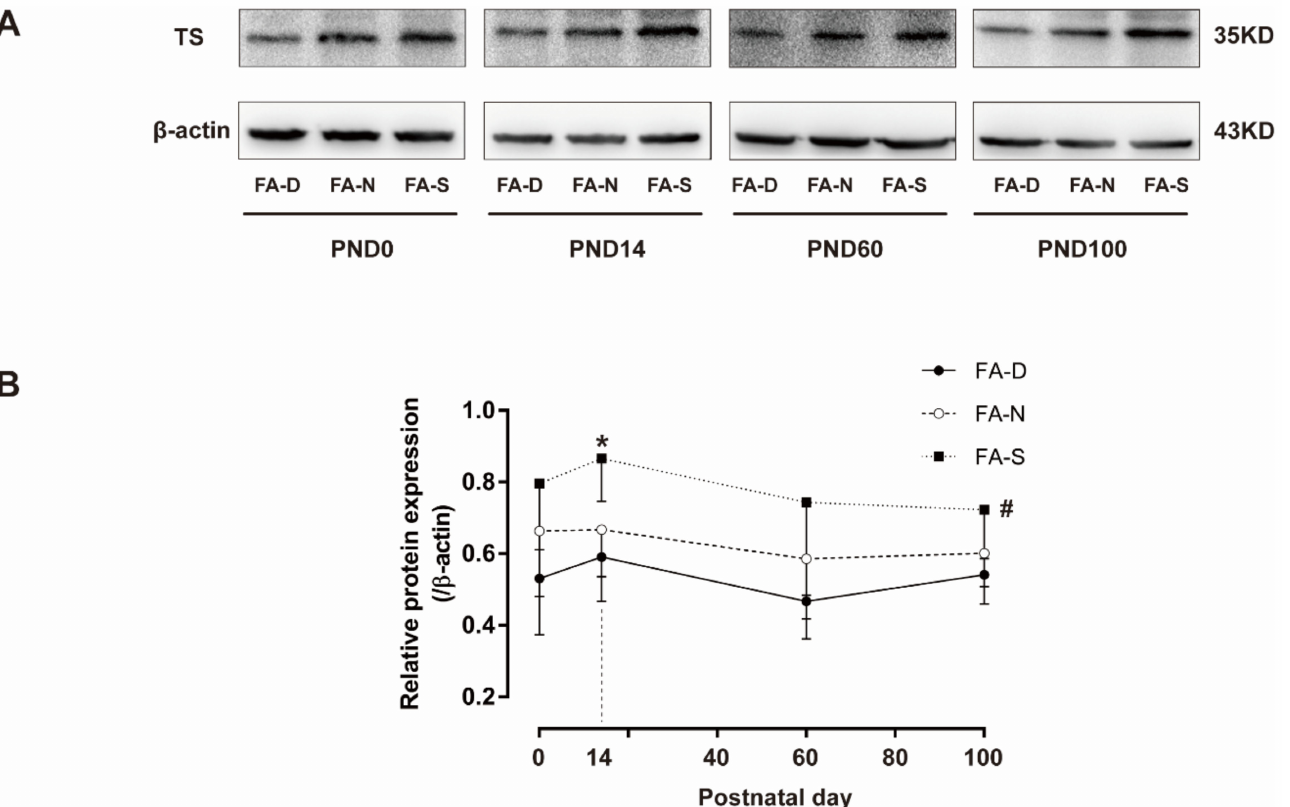
Figure 6. Folic acid supplementation increased the expression of TS in the brain tissue of offspring. Dams and pups were fed as described in Figure 1. ( A ) Representative western blotting of TS and β -actin on PND0, PND14, PND60, and PND100. ( B ) The protein expressions of TS quantified by western blotting were normalized to β -actin on PND0, PND14, PND60, and PND100. Data are expressed as mean ± SD ( n = 5 brains/group). * p < 0.05, FA-S group compared with FA-N and FA-D group on PND14. # p < 0.05, FA-S group compared with FA-D group on PND0, PND14, PND60, and